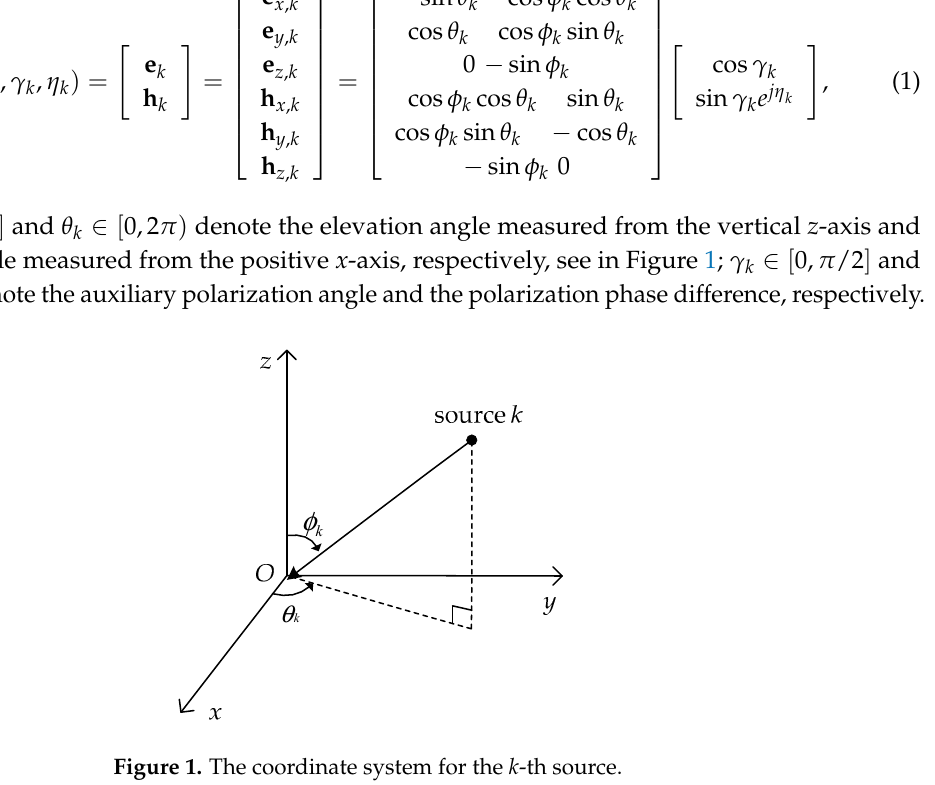
Figure 1. The coordinate system for the k -th source.